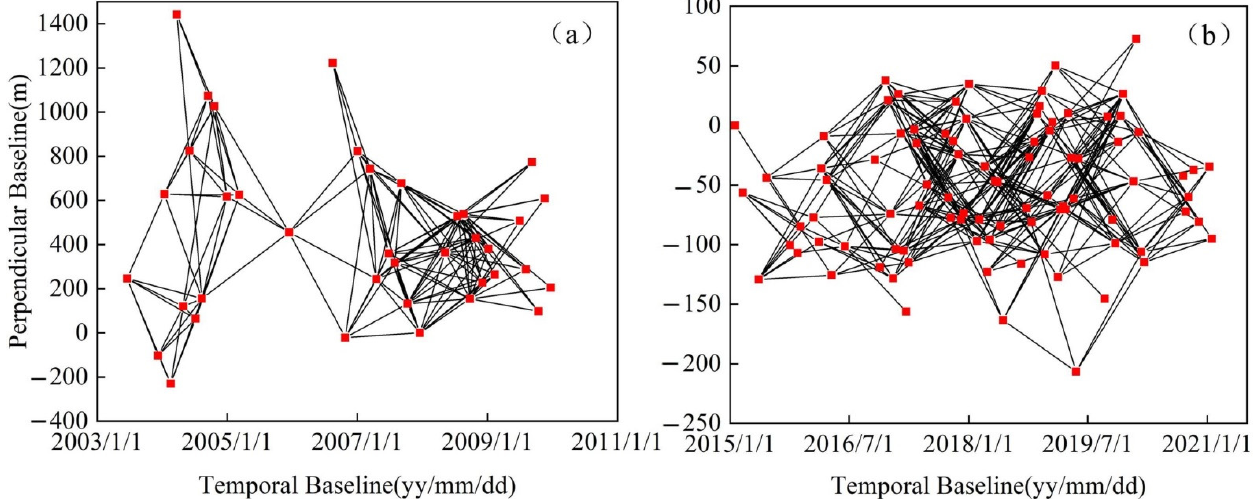
Figure 3. Temporal and perpendicular baseline maps of ( a ) ENVISAT ASAR and ( b )